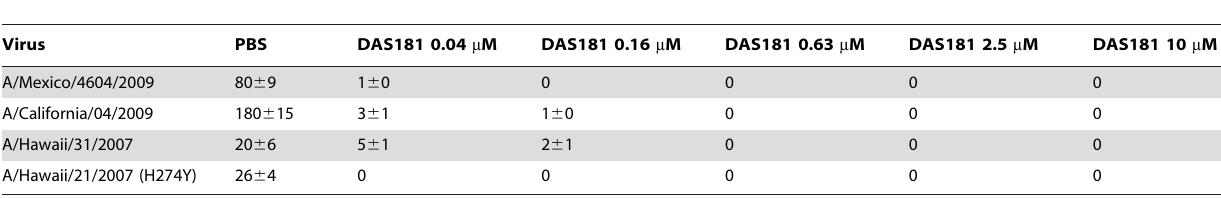
Table 1. DAS181 inhibits pandemic IFV A(H1N1): Number of Viral Foci in MDCK culture (per well).